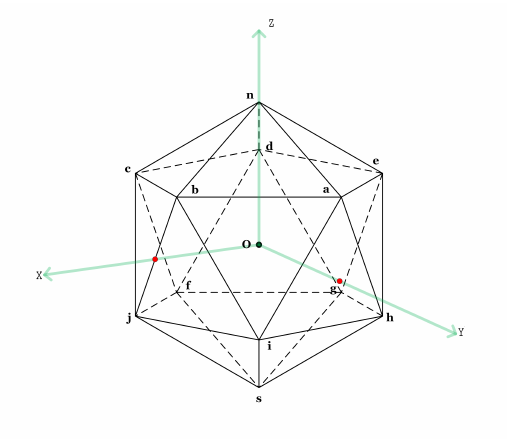
Figure 4: Standard icosahedron used to construct a modified EGI descriptor of a cluster